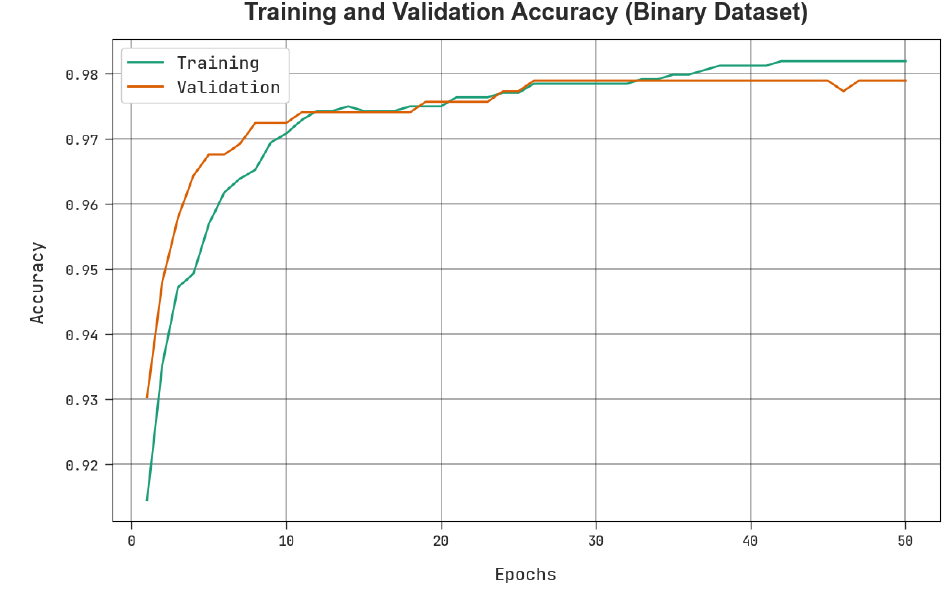
Figure 5. Accuracy curve of the H3SC-DLIDS approach on a binary dataset.